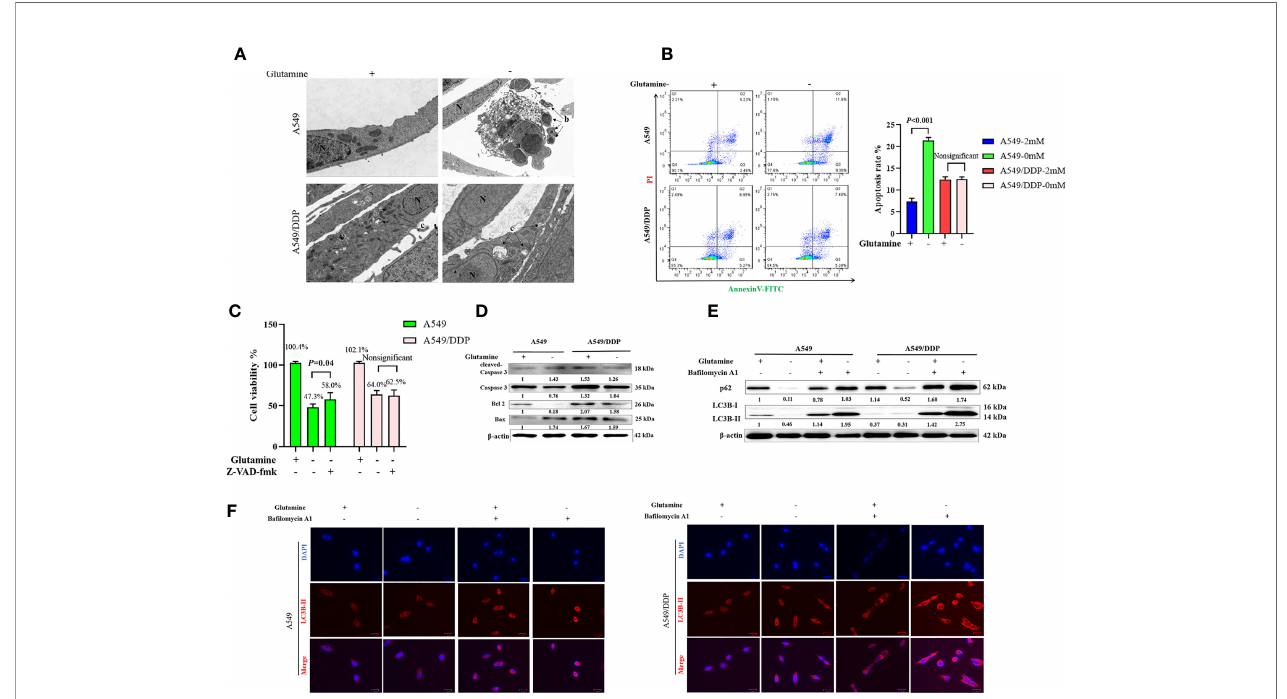
FIGURE 2 | A549/DDP cells show higher levels of autophagic activity and greater apoptosis resistance characteristics during glutamine deprivation. (A) TEM images of A549 and A549/DDP cells cultured with (+) or without ( − ) glutamine (2 mM) for 48 h. a, an apoptotic cell with two nuclear fragments; b, apoptotic bodies; c, autophagosomes or initial autophagic vacuoles; N, nucleus. Bar, 2 m m. (B) Annexin V-FITC/PI apoptosis detection assay for A549 and A549/DDP cells cultured with (+) or without ( − ) glutamine (2 mM) for 48 h. (C) Effects of Z-VAD-fmk (5 m M; 48 h) on A549 and A549/DDP cells during 48 h of glutamine deprivation. (D) Blots show expression of key proteins involved in apoptosis in A549 and A549/DDP cells cultured with (+) or without ( − ) glutamine (2 mM) for 48 h. b -actin served as a loading control. (E) Blots show expression of key proteins involved in autophagy in A549 and A549/DDP cells after BA1 treatment (10 nM; 48 h) cultured with (+) or without ( − ) glutamine (2 mM) for 48 h. b -actin served as a loading control. (F) Immunostaining of LC3B in A549 and A549/DDP cells after BA1 treatment (10 nM; 48 h) cultured with (+) or without ( − ) glutamine (2 mM) for 48 h. Red = LC3B; blue = DAPI. All experiments were repeated at least three times, and results were expressed as mean ±